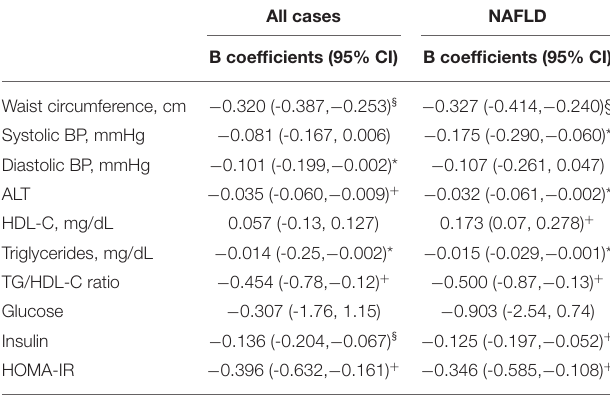
coefficients between RMM and clinical variables. All